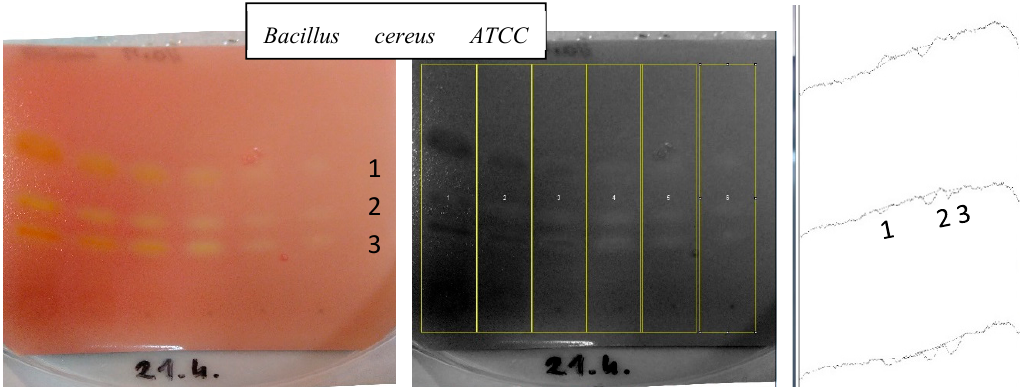
Figure 1. Determination of peak areas of active metabolites visualized by TLC bioautography. The example shows the TLC plate with MeOH extract of turmeric, covered with B. cereus ATCC 10876 strain, which was developed on NP silica gel TLC plates by using MeOH: DCM (0.5:99.5 v/v) as the mobile phase. The picture on the right shows the obtained densitometric data from the program.